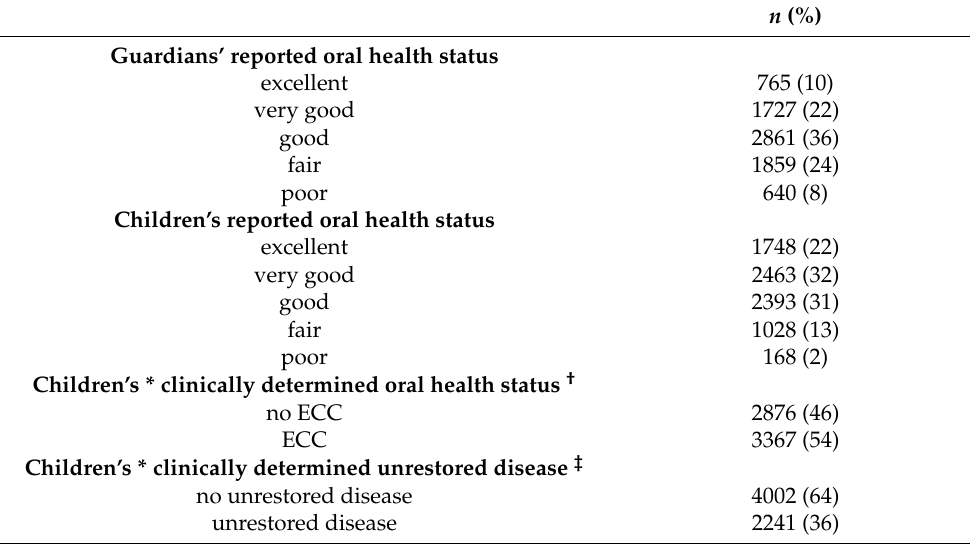
Table 2. Guardians’ and children’s reported oral health status and the children’s clinically determined oral health status (early childhood caries,